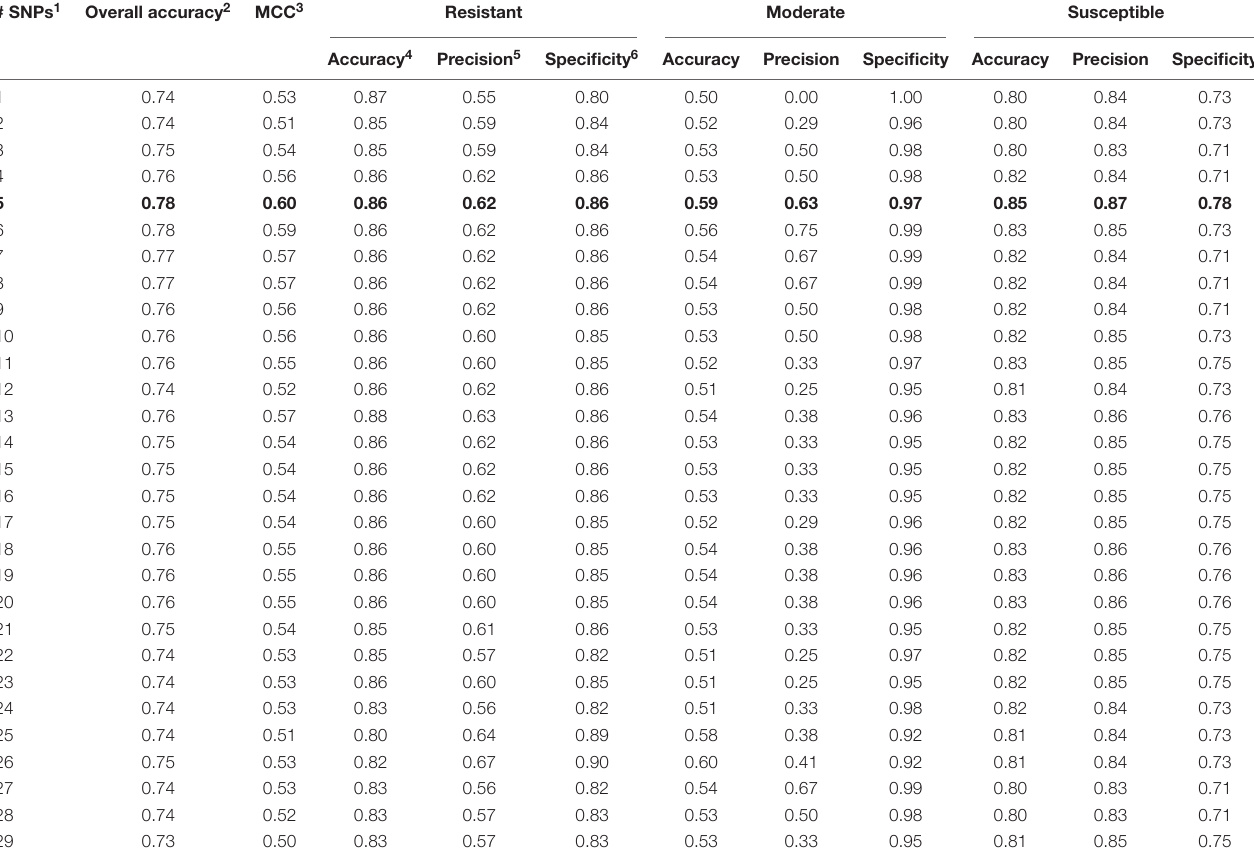
TABLE 1 | Summary of SVM classification accuracy metrics based on the number of predictors.